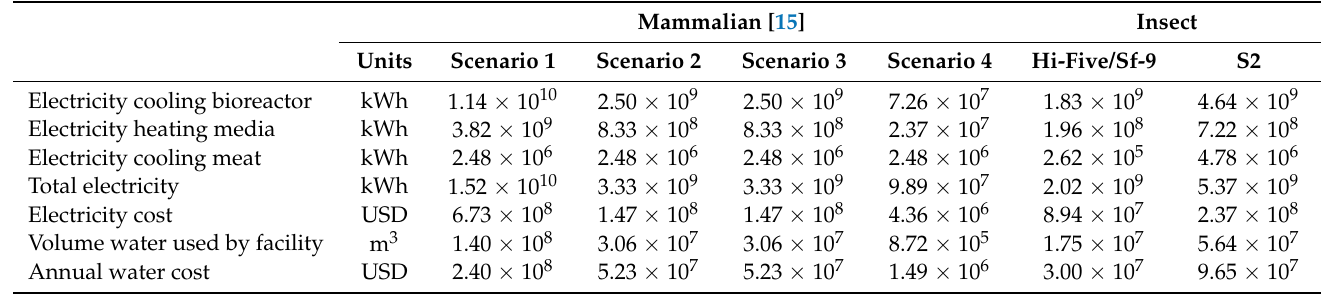
Table 5. Outcome values relating to utilities produced by the model for four mammalian scenarios proposed in the Risner et al. paper compared to outcomes for Hi-Five/Sf-9 and S2 insect cells [15].